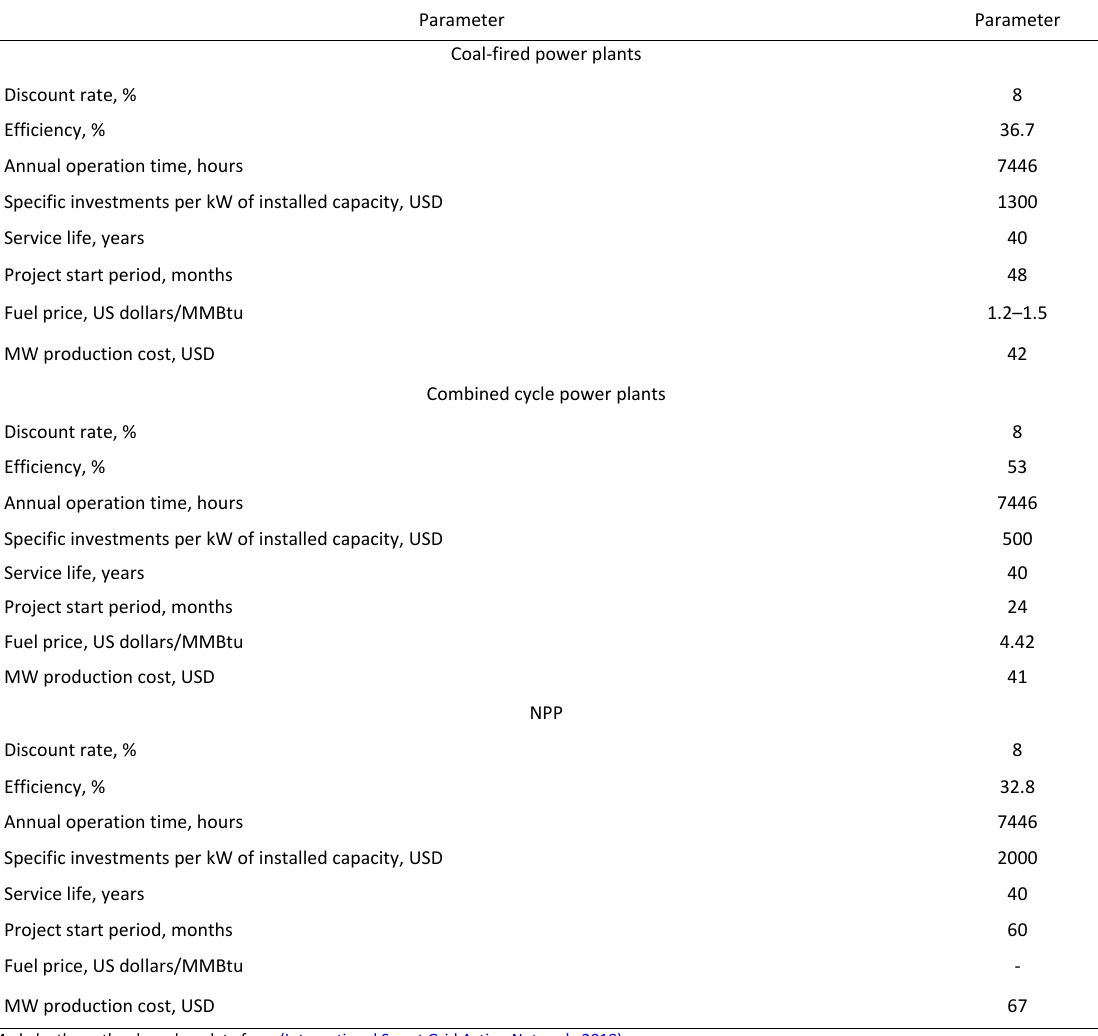
Table 1: Basic energy technology parameters